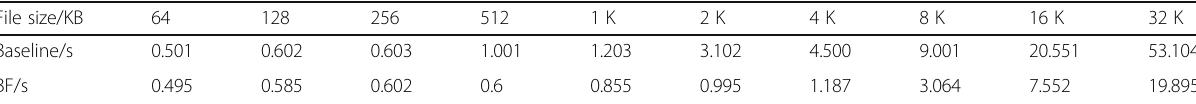
Table 6 Total time overhead for files without duplicates